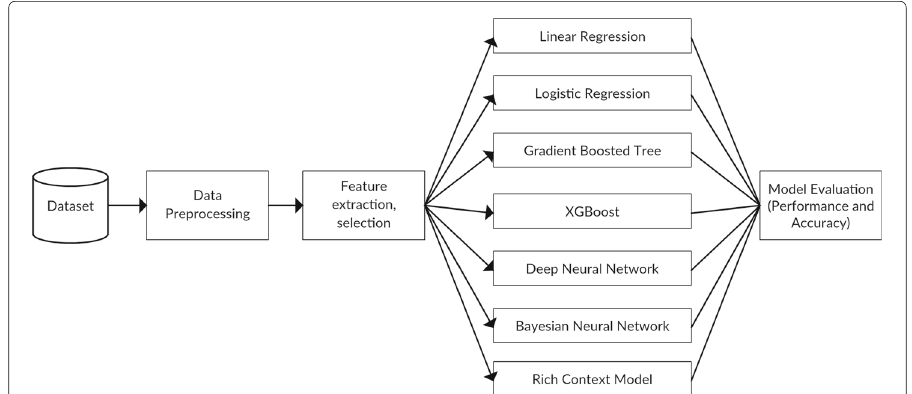
on Fig. 1. There are four main steps: data preprocessing of collected data (Dataset); feature extraction and selection; applying seven models: linear regression, logistic